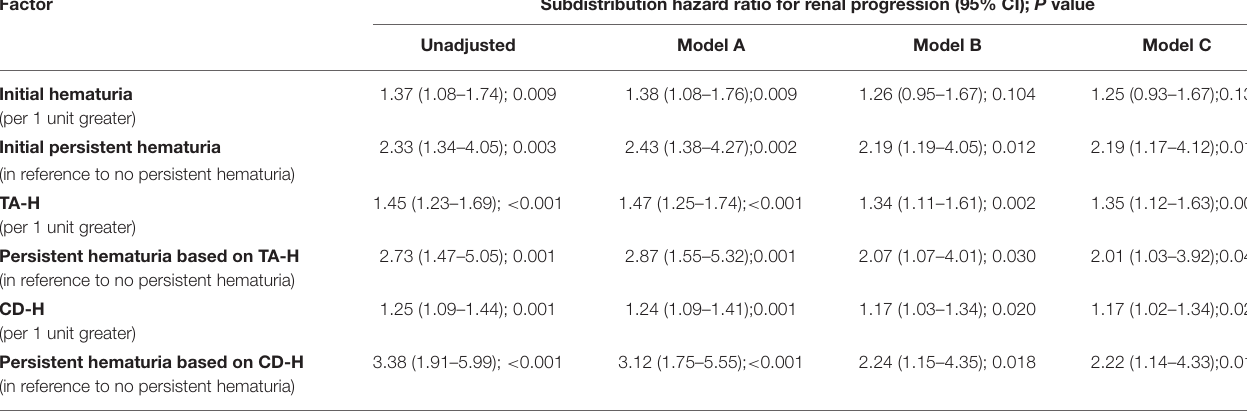
TABLE 4 | Microhematuria and risk of renal progression in competing risk regression